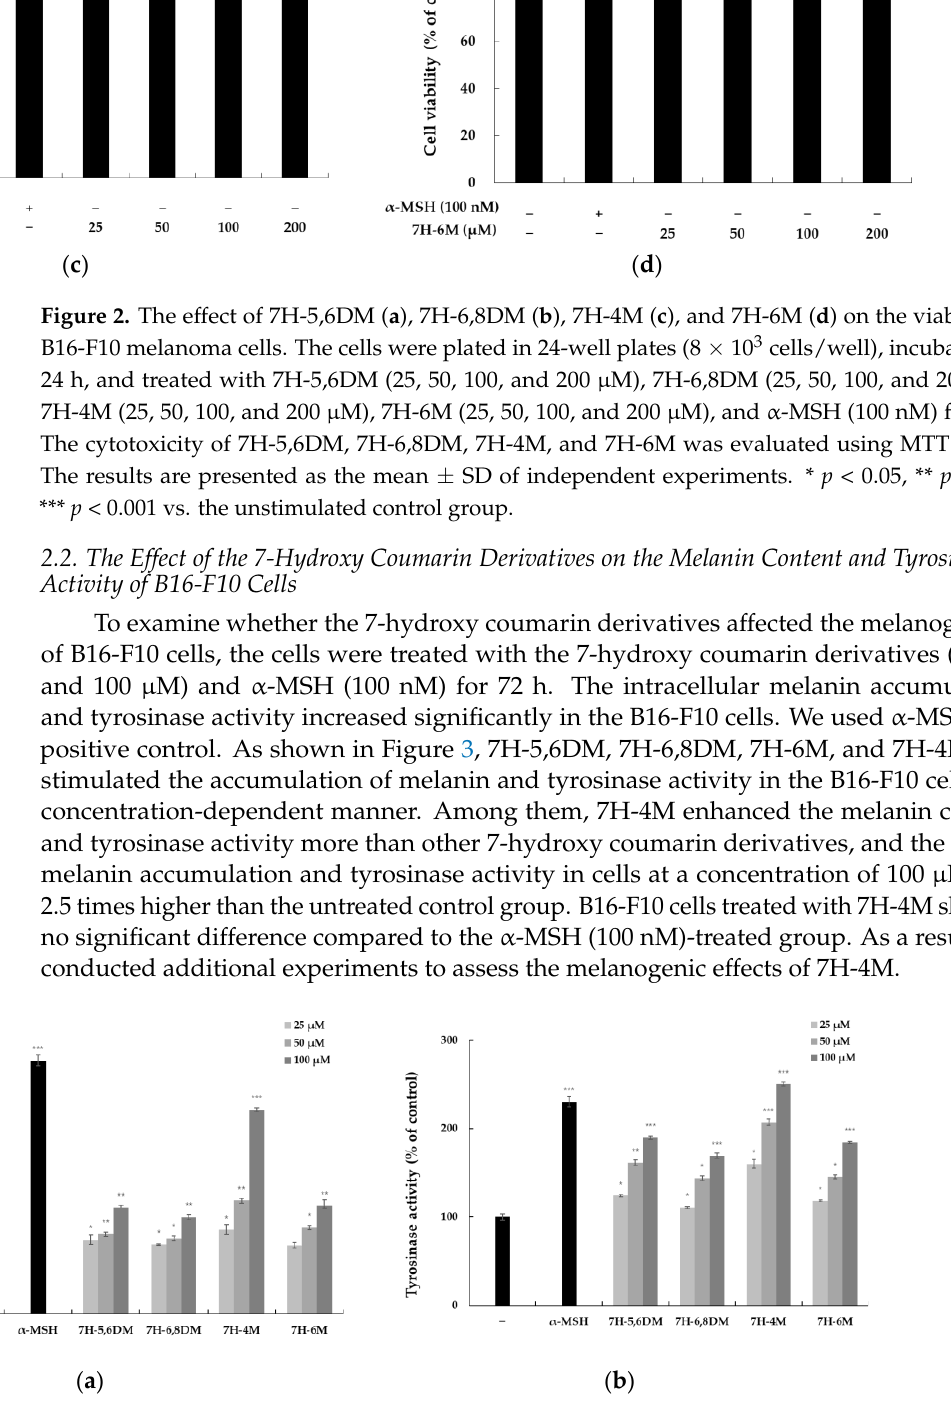
Figure 3. The effect of 7H-5,6DM, 7H-6,8DM, 7H-4M, and 7H-6M on the production of melanin ( a ) and tyrosinase activity ( b ) in B16-F10 melanoma cells. The cells were plated in 6-well plates (5 × 10 4 cells/well), incubated for 24 h, and treated with 7H- 5,6DM (25, 50, and 100 μM), 7H -6,8DM (25, 50, and 100 μM), 7H - 4M (25, 50, and 100 μM), 7H - 6M (25, 50, and 100 μM), and α -MSH (100 nM) for 72 h. α -MSH was used as the negative control. The results are presented as the mean ± SD from inde- pendent experiments. * p < 0.05, ** p < 0.01, *** p < 0.001 vs. the control group.